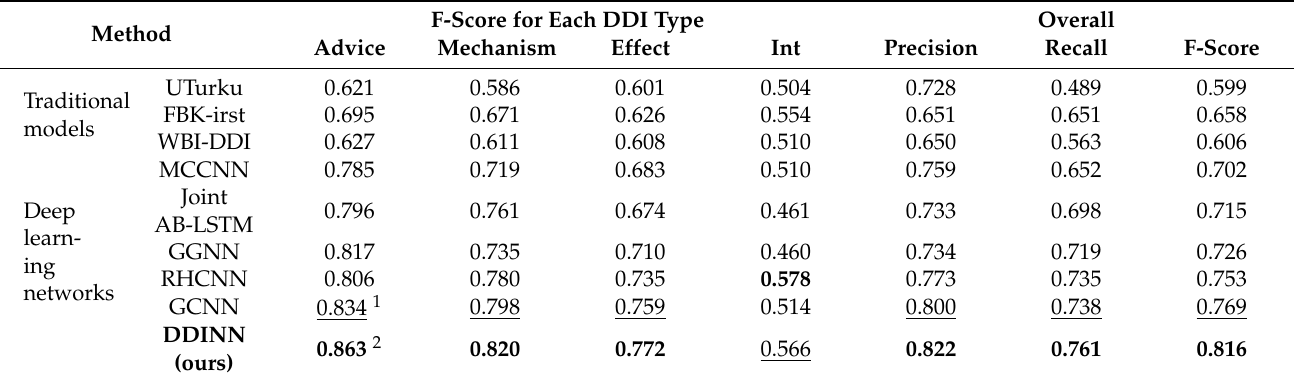
Table 3. Performance comparisons with other DDI prediction methods.